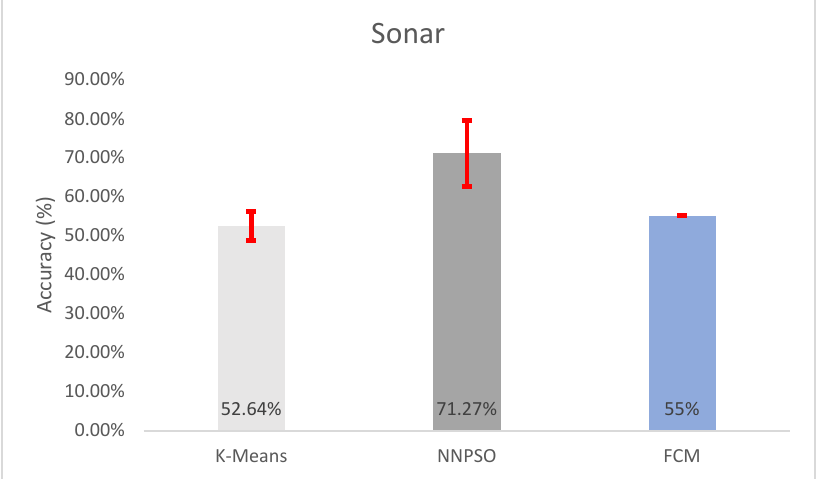
Figure 24. Accuracy of the algorithms on the Sonar data set.